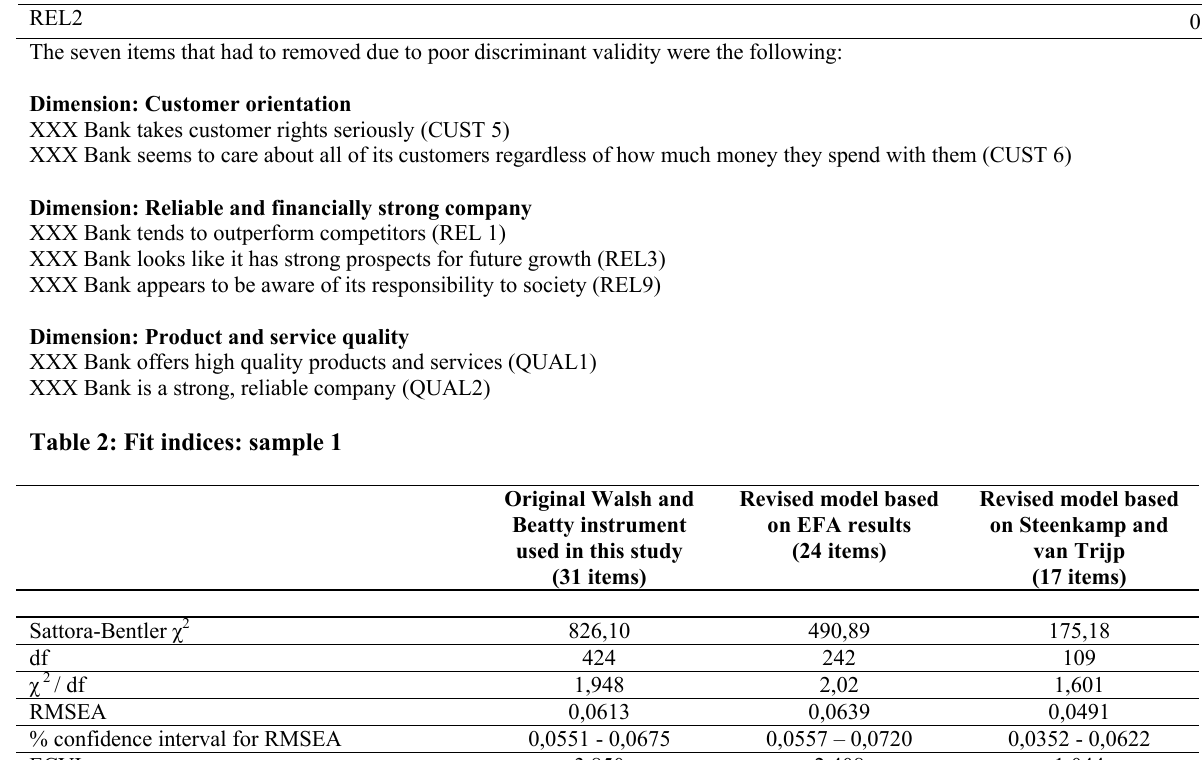
Original Walsh and Beatty instrument used in this